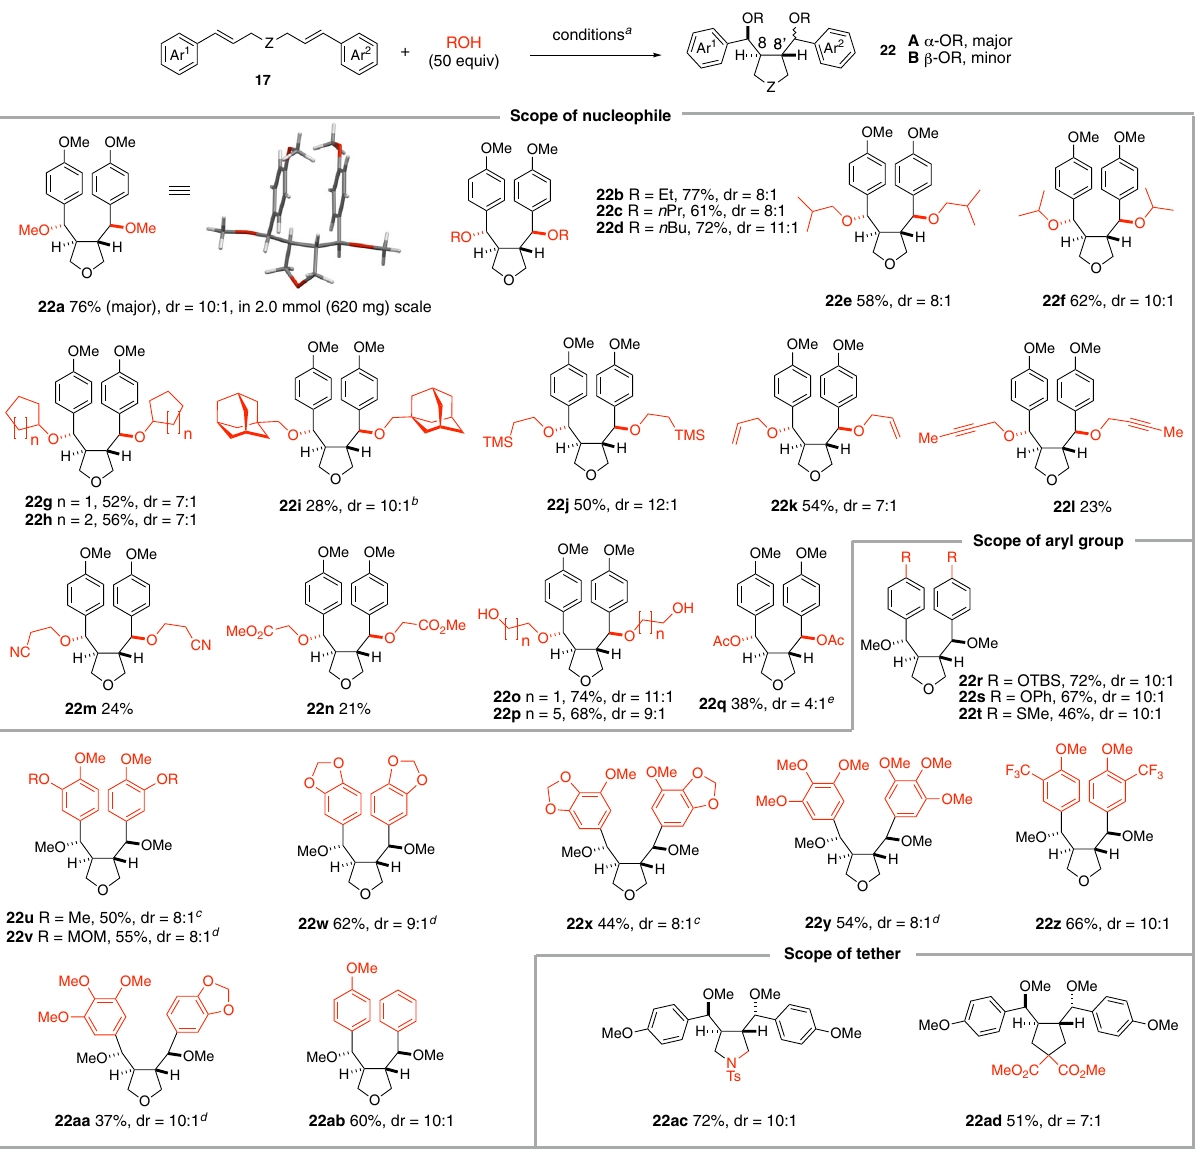
NATURE COMMUNICATIONS| (2022) 13:3481